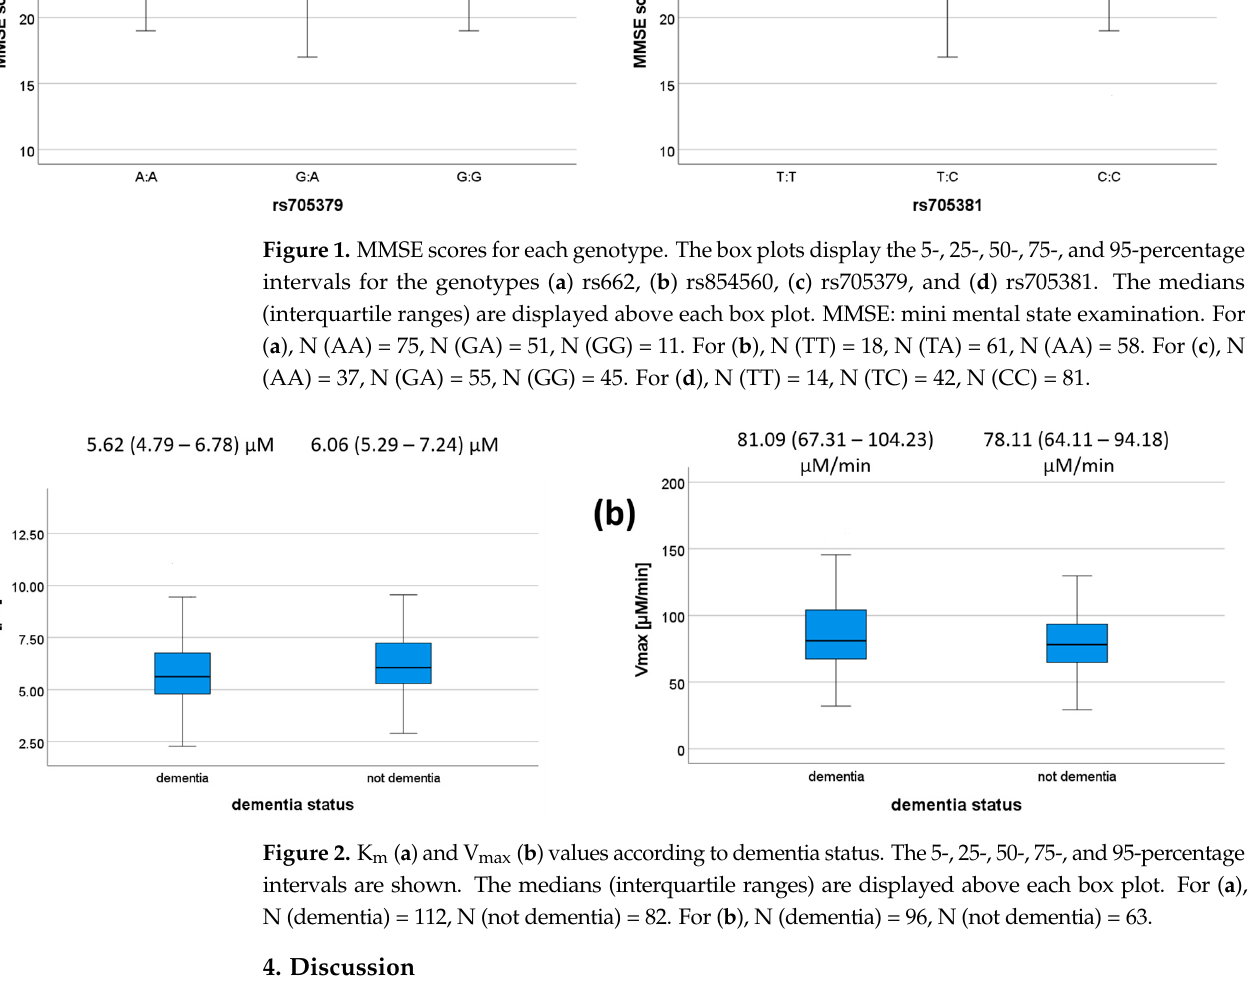
Table 7. The associations between PON1 genetic/enzyme-kinetic parameters (K m , V max , and genotype) and cognitive parameters (MMSE and presence of dementia). Correlation coefficients are shown only for comparisons of numeric parameters .